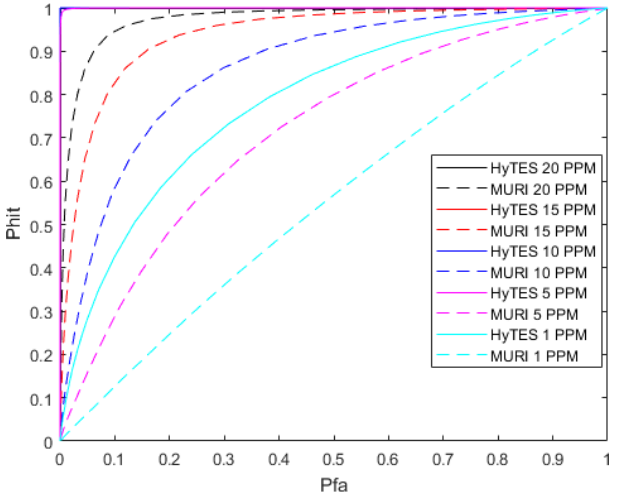
Figure 6. ROC curves for matched-filter detection experiment. Re- sults indicate high detection for most HyTES cases. Performance for MURI is high for 15 and 20ppm but low for 1 to 5ppm (see Table S1 in the Supplement for the area under each of the MURI ROC curves).